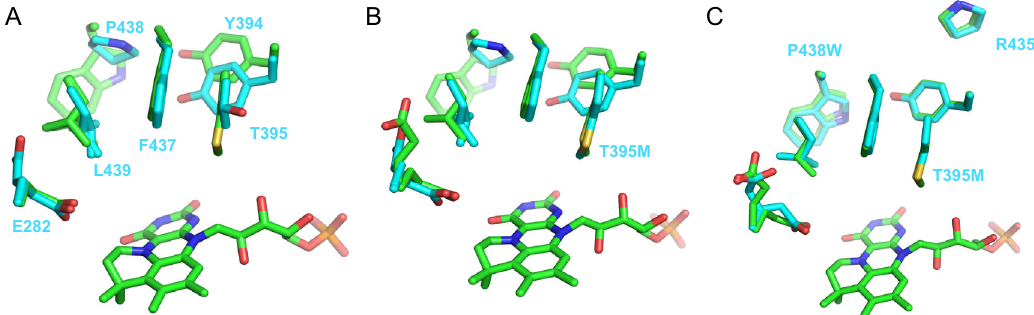
Fig. 4 Comparison of the TaFdcV and AnFdc wild-type and variant active sites. Overlay of Ta FdcV (green, 7NEY [10.2210/pdb7NEY/pdb]) with A An Fdc wild-type (blue, 4ZA4 [10.2210/pdb4ZA4/pdb]), B An FdcI (blue, 7NF3 [10.2210/pdb7NF3/pdb]) and C An FdcII (blue, 7NF4 [10.2210/pdb7NF4/pdb]) crystal structures ( An Fdc variant residue numbering according to An